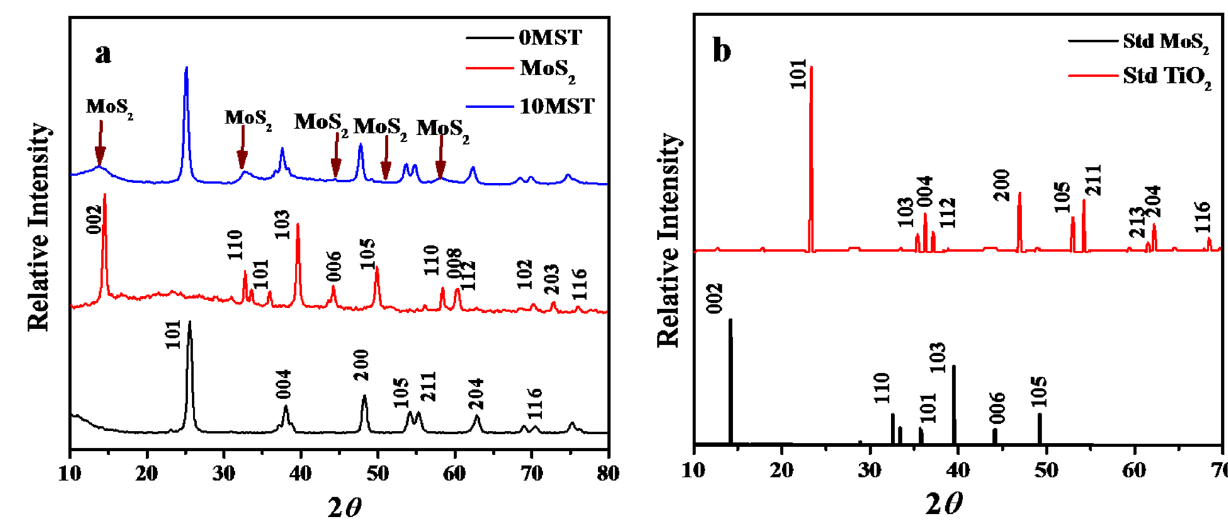
Fig. 1 a XRD pattern of the TiO 2 hollow microsphere (0 MST), MoS 2, and 10 MST, b XRD pattern of Std MoS 2 and Std TiO